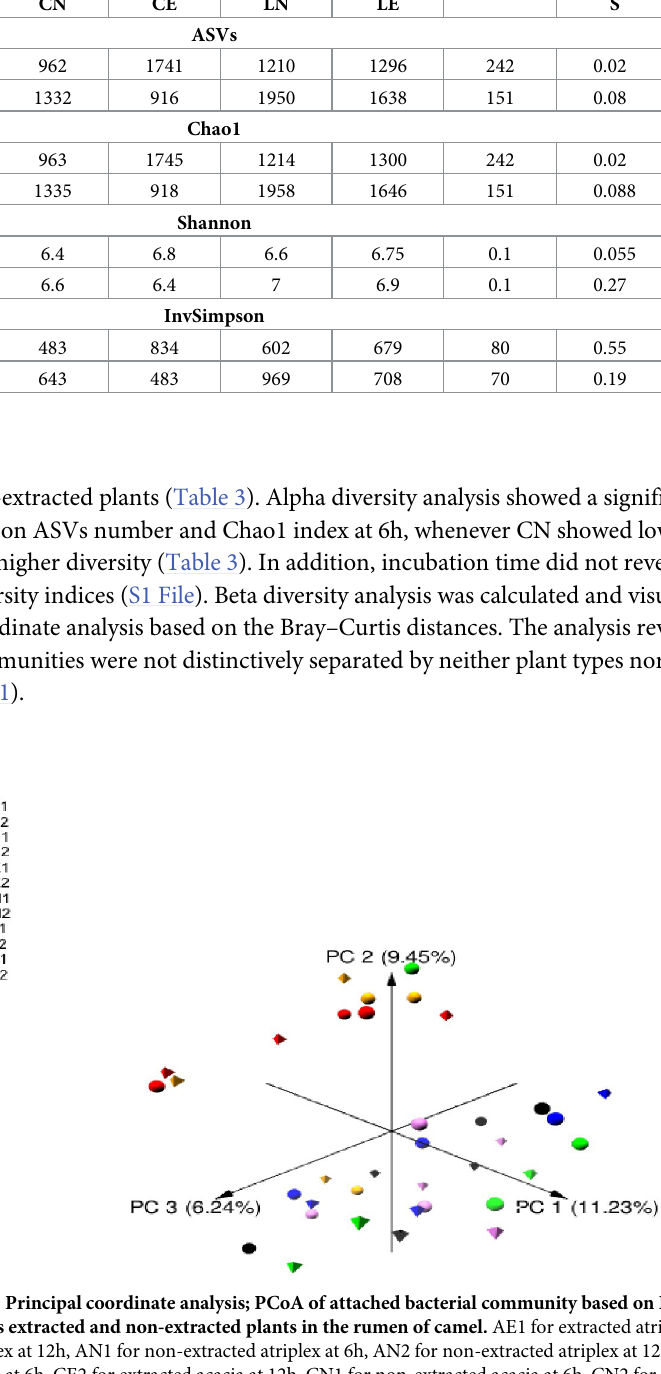
Table 3. Average of ASVs number, Chao1, Shannon, and Inverse Simpson indices of bacterial community colonizing to extracted and non-extracted atriplex, aca- cia, and leucaena at 6 and 12 hours incubations. Incubation time (h)